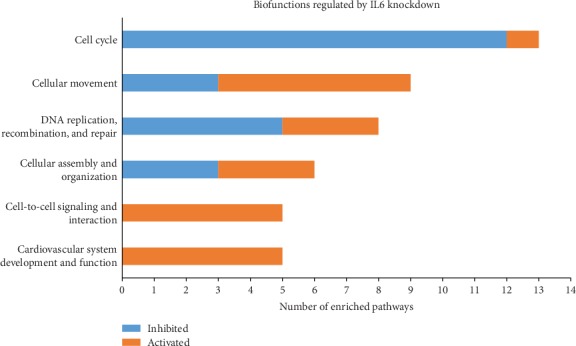
Functions regulated by IL6 knockdown in human endothelial cells. Using Ingenuity Pathway Analysis (IPA), diseases and biofunctions regulated by IL6 knockdown in human endothelial cells were evaluated. Diseases and biofunctions were classified into different categories based on the Ingenuity Knowledge Base classification. Activated diseases or biofunctions are indicated in orange, and inhibited diseases or biofunctions are indicated in blue. Categories which include 3 or more functions are shown. Functions with Benjamini-Hochberg's estimated false discovery rate < 0.05 and z − score<−2 or >2 were considered as enriched.